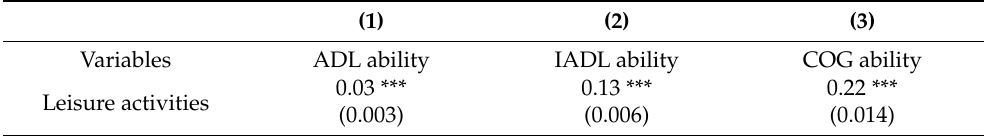
Table 9. Robustness